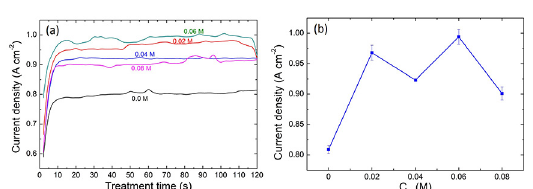
Figure 2. (a) Current density as a function of treatment time and (b) average current as a function of C